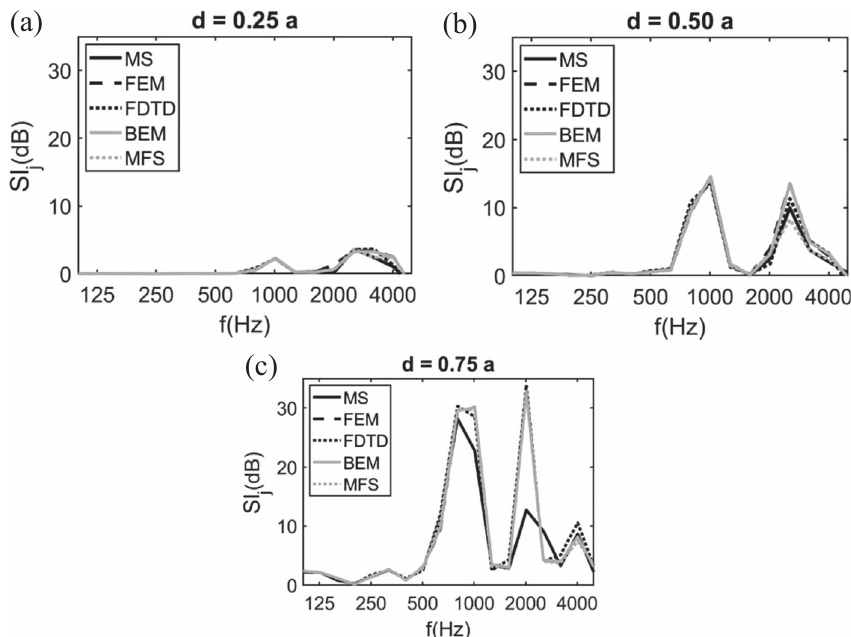
Figure 3. SI j vs. frequency, in one-third octave bands, for all the considered methods: (a) d = 0.25 a ; (b) d = 0.5 a ; (c) d = 0.75 a